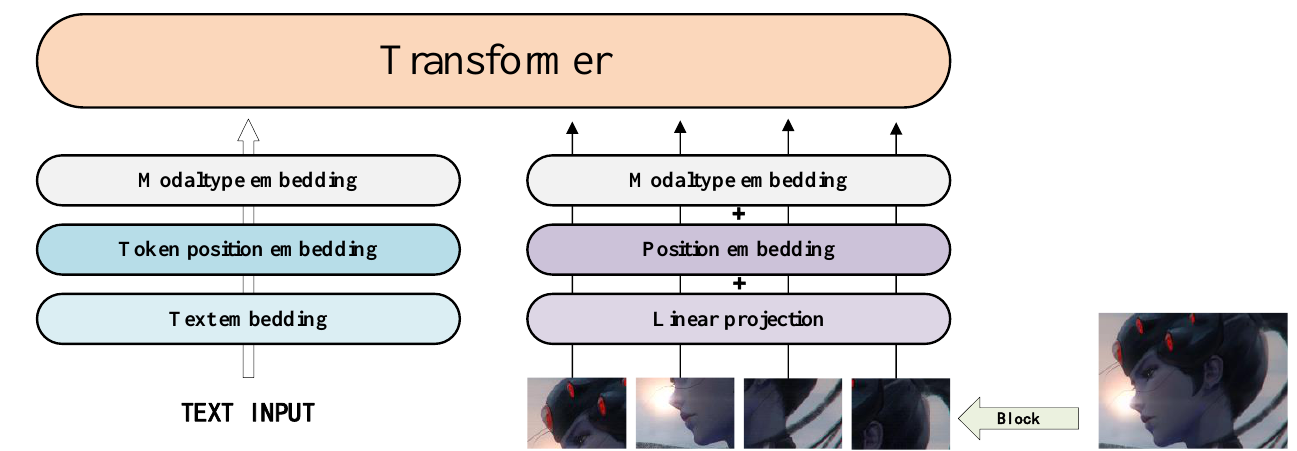
Figure 9. Overview of ViLT framework.